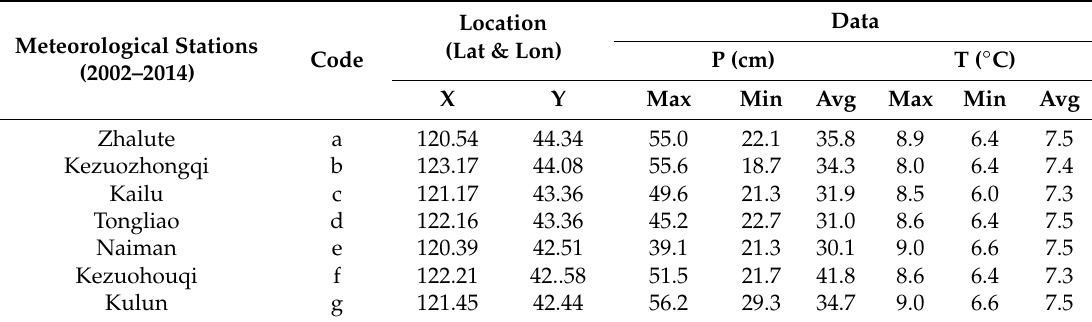
Table 1. Meteorological stations’ information in